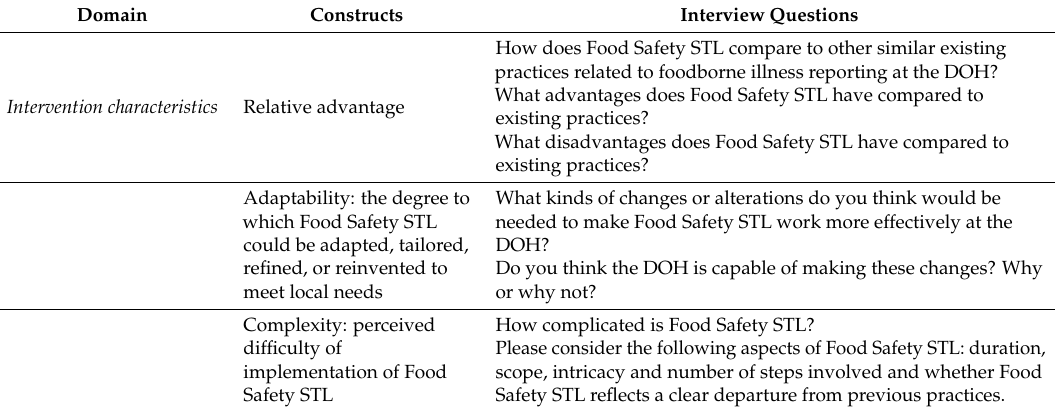
Table 1. Interview questions and Consolidated Framework for Implementation Research (CFIR) domains and constructs for evaluation of Dashboard implementation in the St. Louis Department of Health